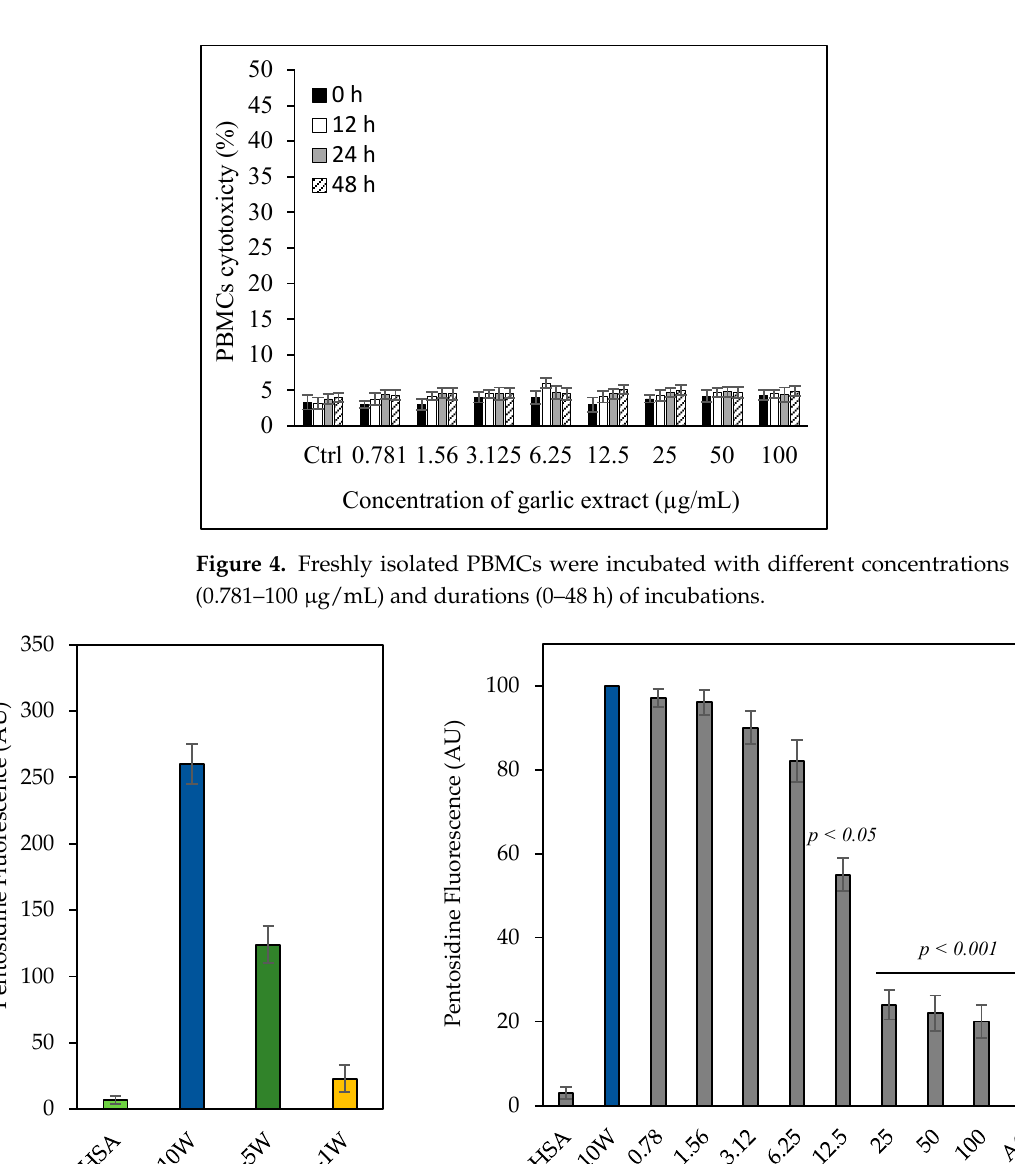
Figure 4. Freshly isolated PBMCs were incubated with different concentrations of garlic extract